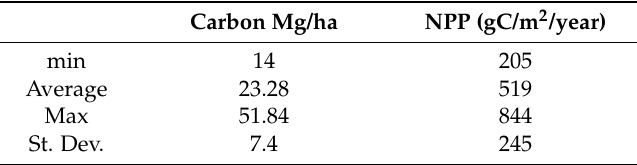
Table 8. Reference values for the study area.